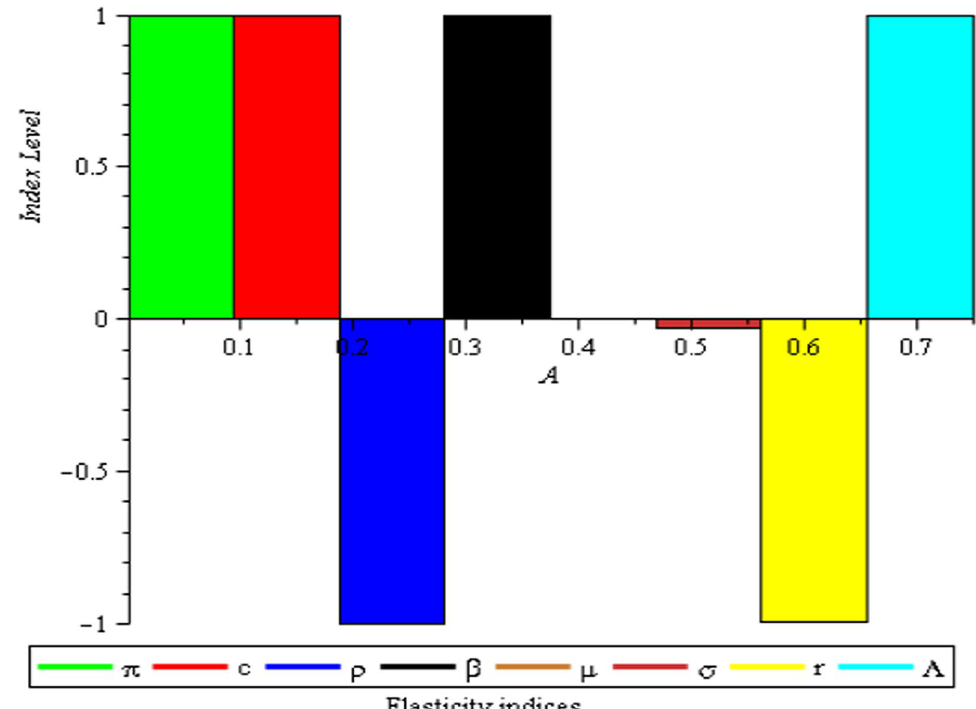
Fig. 1 Normalized local sensitivity index of R 0 on each